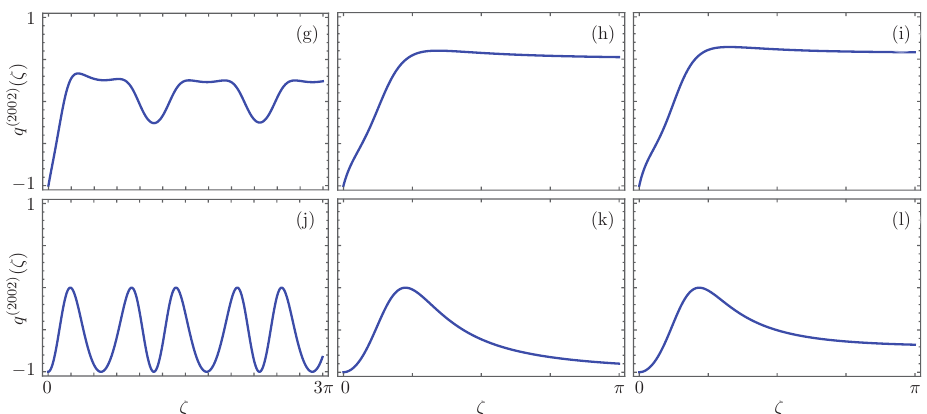
Figure 5. Photon bunching and anti-bunching shown in terms of the q ( 2002 ) ( ζ ) parameter for different realizations of the effective -symmetric dimer. The first row, ( a – c ), shows balanced gain-loss, PT the second row, ( d – f ), shows gain-gain, the third row, ( g – i ), shows gain-passive, and the fourth row, ( j – l ), shows both passive-loss and loss-loss configurations in the -symmetric regime, the first PT = 0.5, the Kato point with = 1, the second column, and the broken symmetry γ γ column with | | | | = γ regime, the third column with | |